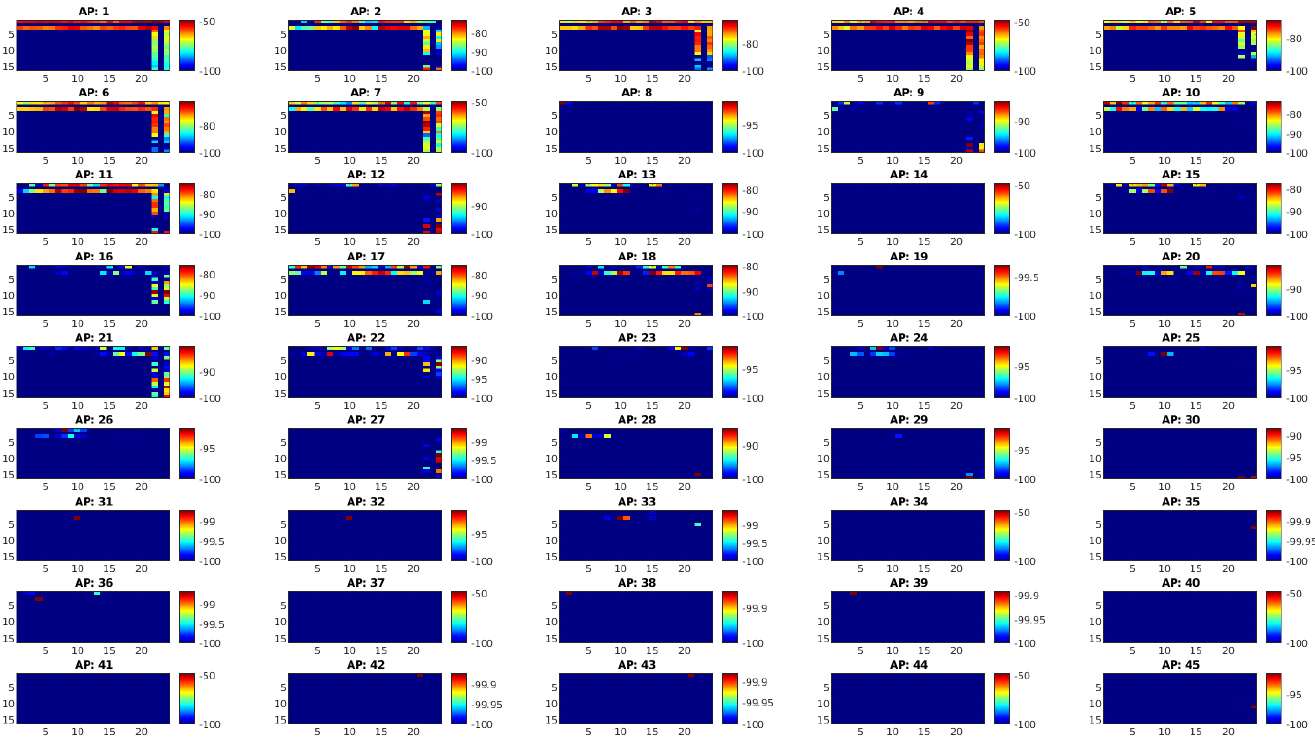
Figure 4. RSSI heat map or coverage map shows APs coverage ranges within the surveyed